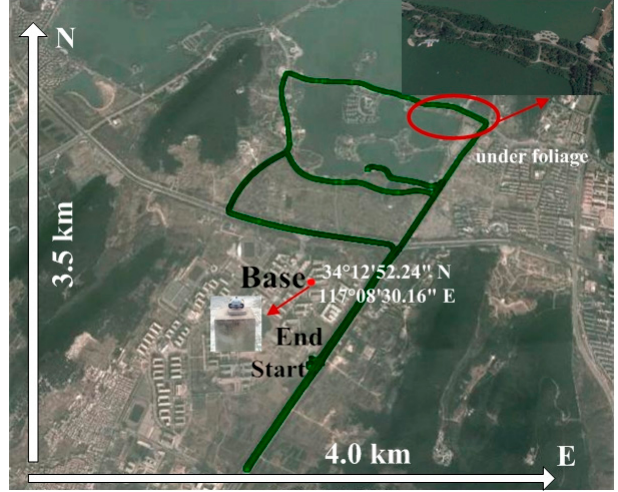
Figure 2. Ground trajectory of vehicular test.